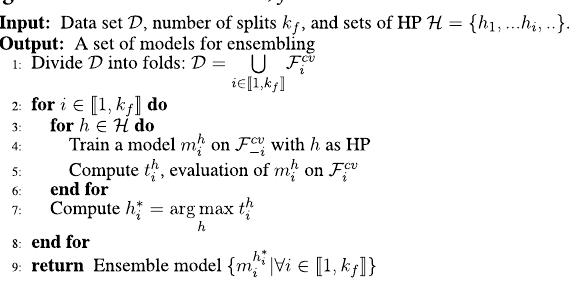
Algorithm 4. Model selection, f bfcv